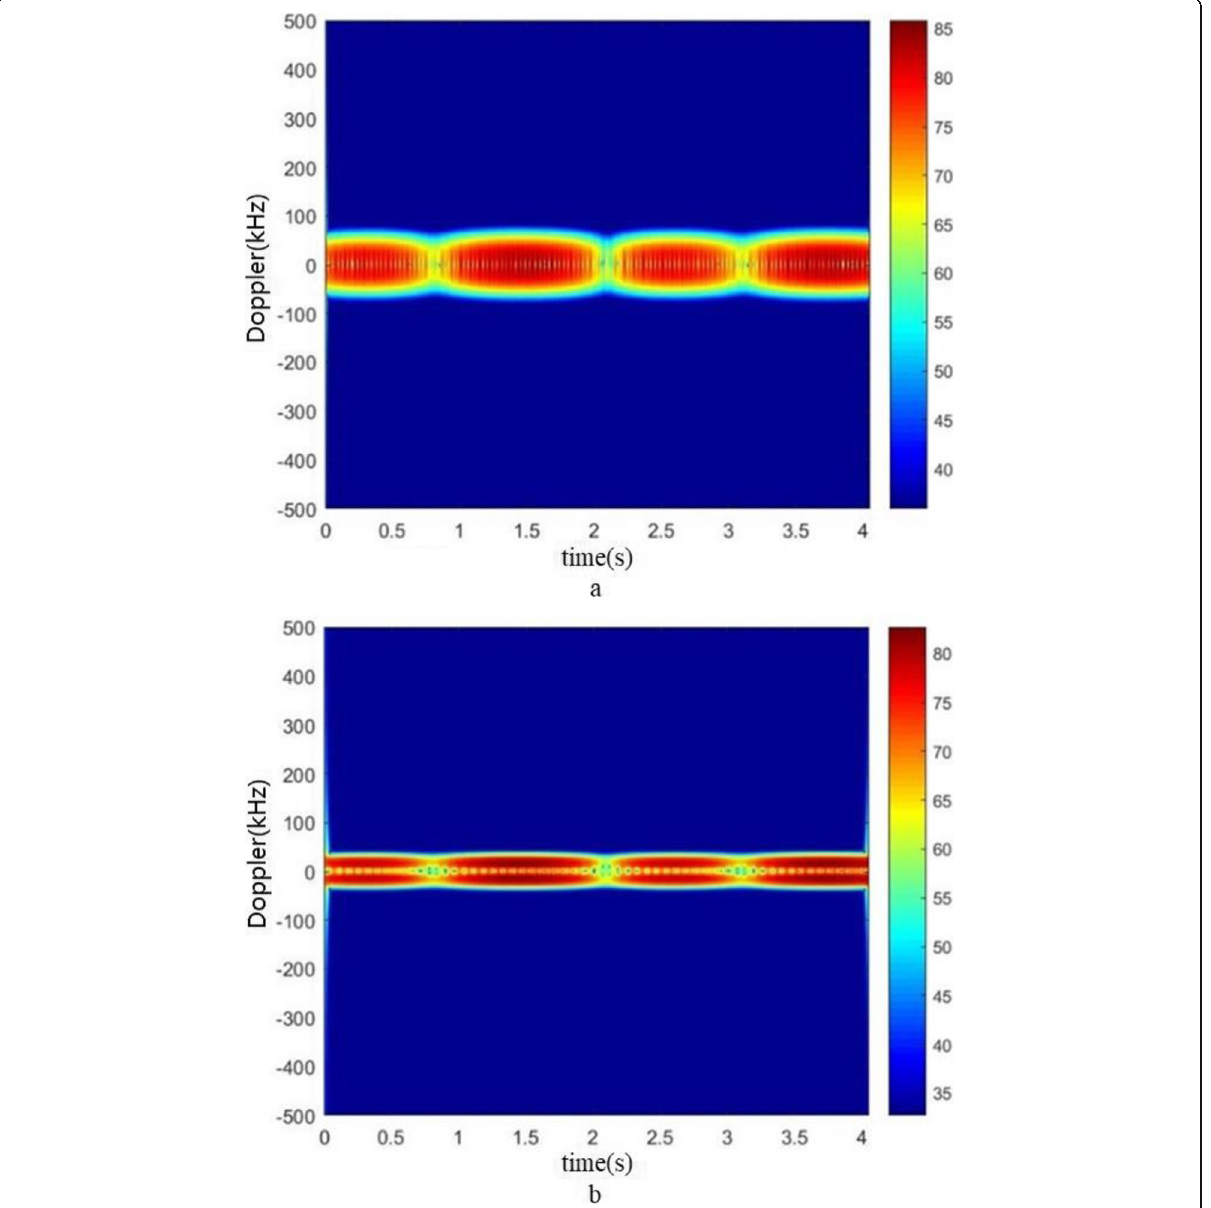
Fig. 11 Micro-Doppler spectrum of the chaff cloud with different sampling rates: a 4096 points/s sampling rate and b 10240 points/s sampling